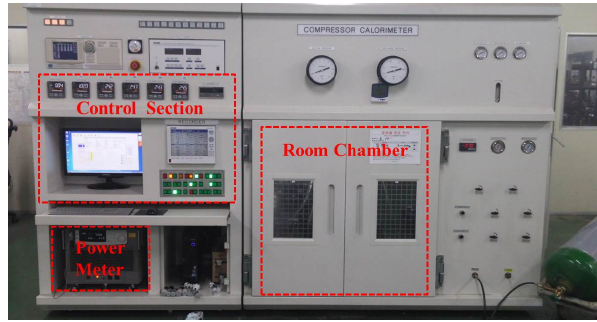
Figure 15. Experimental calorimeter for the test of prototype.